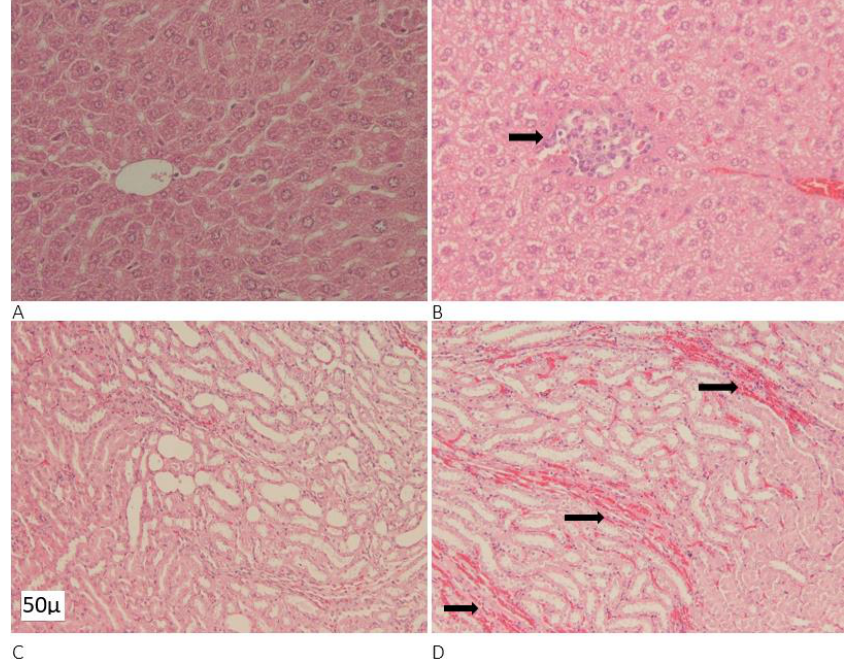
Figure 6. Cross-section of HE stain A. normal B. DPP treatment at a dose of 56 mg/kg/d on mouse liver (arrow=lymphocytic infiltration); C. normal D. DPP treatment at a dose of 56 mg/kg/d on mouse kidney (arrow=congested vessel) (Febrian, 2018; Ziyad,